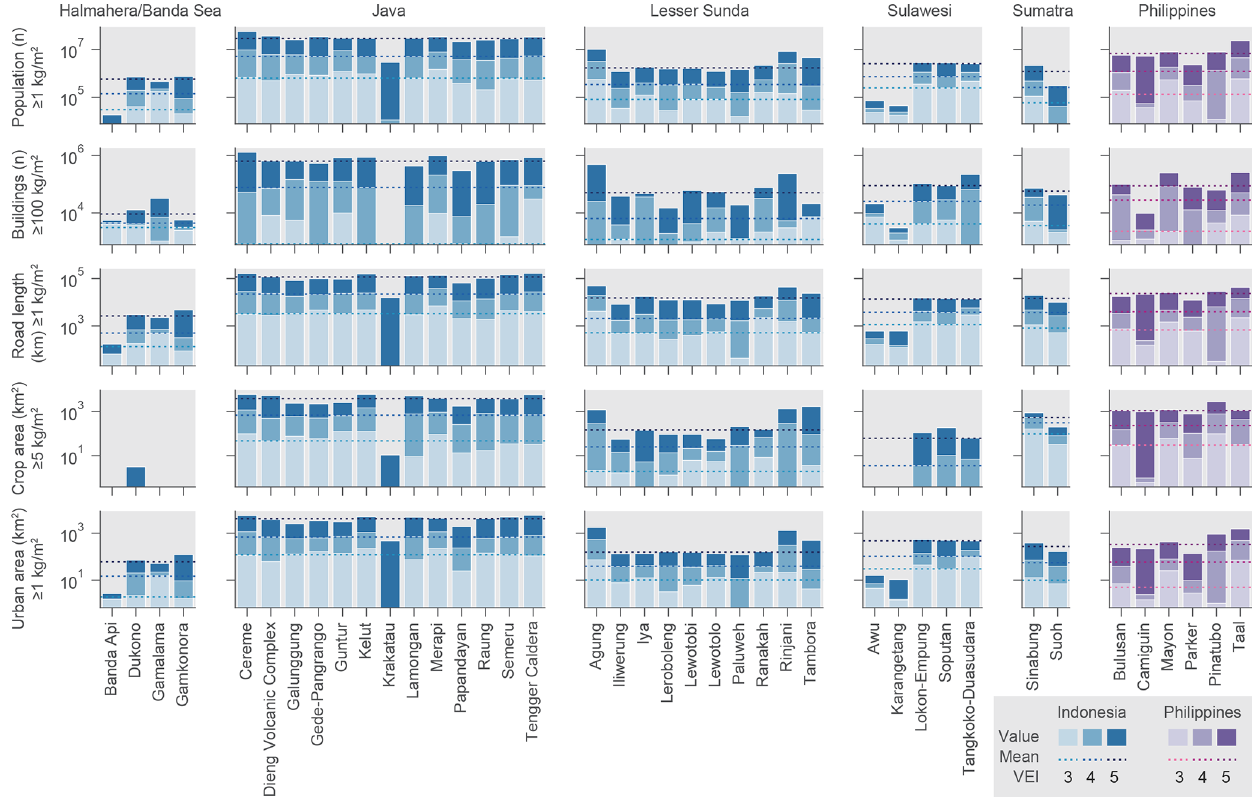
Figure 6. Exposure to tephra fall accumulation summarised per region and exposure type for a conditional exceedance probability of oc- currence of 50%. Overlying (not stacked) bars illustrate the variability in exposure with VEI (with the top of the bar representing exposure for that VEI) and dotted lines the median for the region. Note that specific thresholds of tephra loads (as defined in Sect. 2.2.1) are used for various exposure